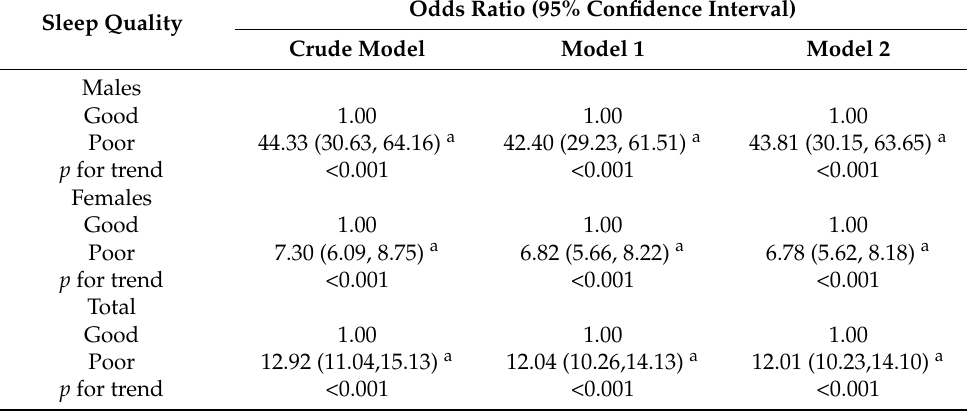
Table 5. The hierarchical logistic regression of depression symptoms for Chinese college students with different sleep